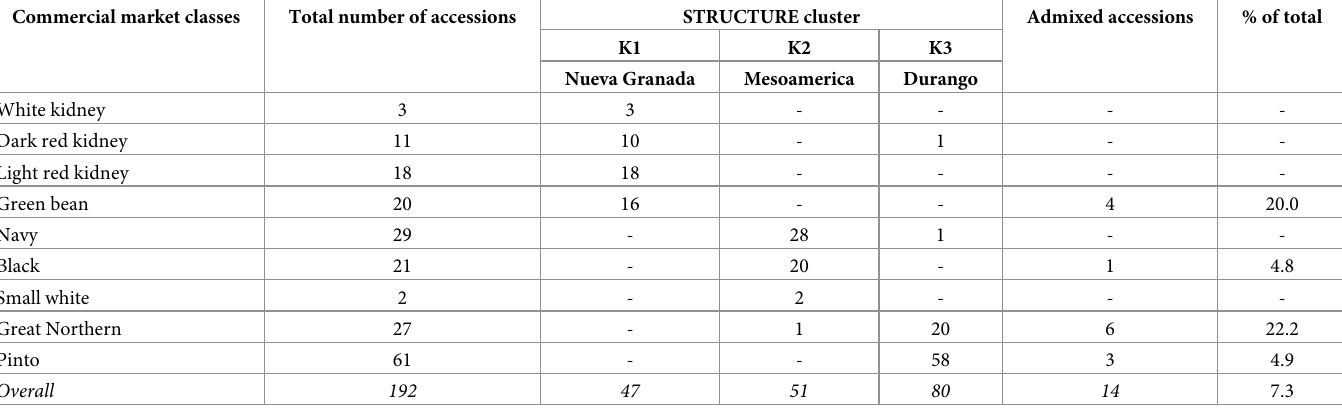
Table 2. Distribution of the 192 commercial market classes into the three SSRs clusters (K = 3) identified by STRUCTURE analysis based on 0.70 membership probability. Commercial market